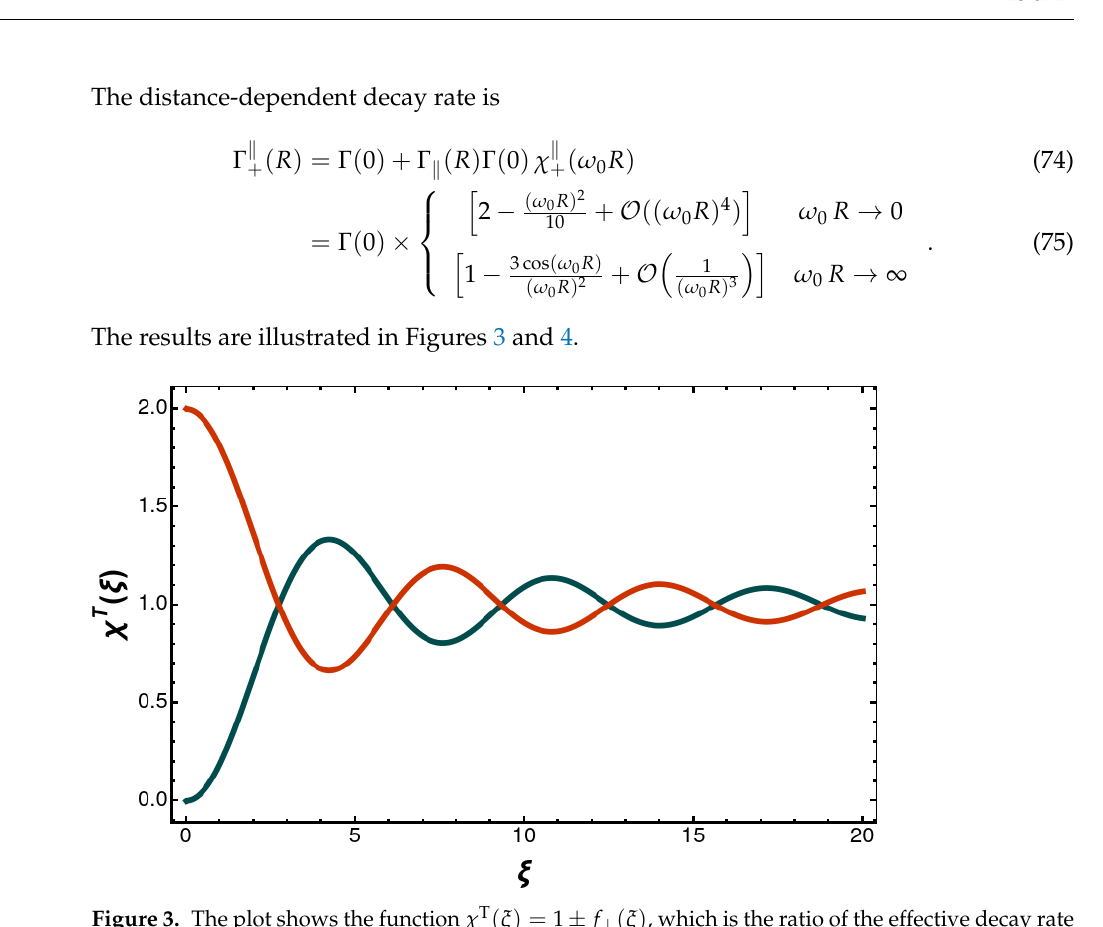
Figure 4. The plot shows the function χ P ( ξ ) = 1 positive sign, and the blue curve corresponds to the negative sign. The positive sign corresponds to the longitudinal superradiant state, whose decay rate, in the short-range limit, assumes a value equal to twice the natural decay